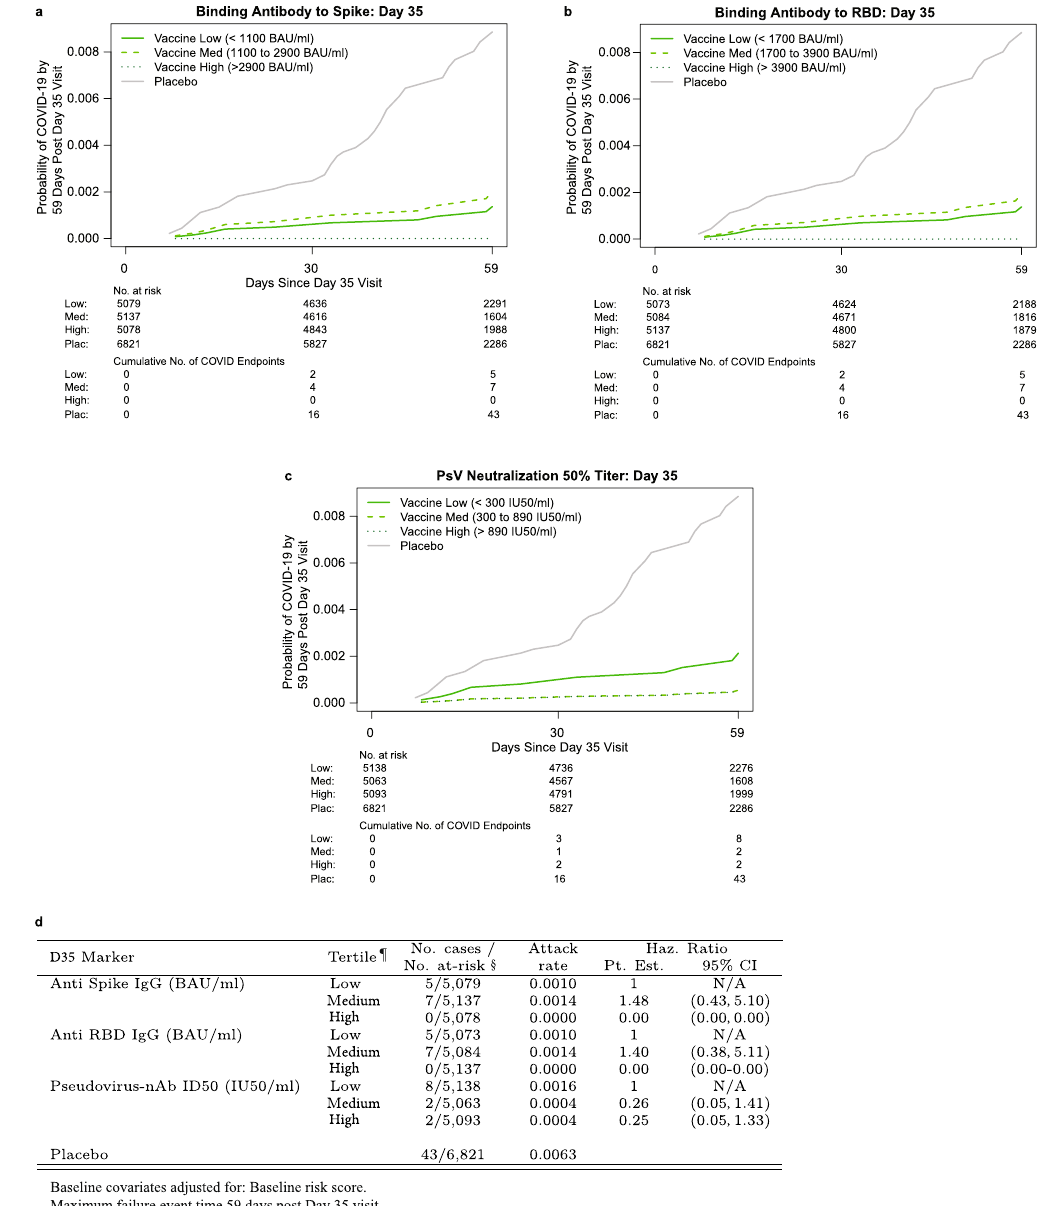
Fig. 3 | COVID-19 risk by D35 antibody marker level in baseline SARS-CoV-2 negative per-protocol vaccine recipients (U.S. study sites). Baseline risk score- adjusted cumulative incidence of COVID-19 by Low, Medium, High tertile of D35 antibody marker level. a , d Anti-spike IgG concentration; b , d anti-RBD IgG con- centration; c , d pseudovirus (PsV) nAb-ID50 titer, where in c the estimate for the High tertile is very similar to that for the Medium tertile and hence appears